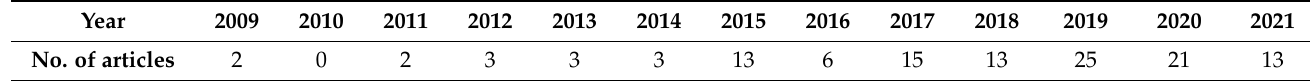
Table 1. Publications by year from 2006 to